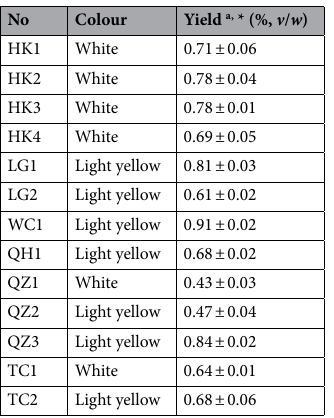
Table 1. Extraction results of EOs of C. lansium seeds. a Values represent the means of three independent replicates ± SD, * P =